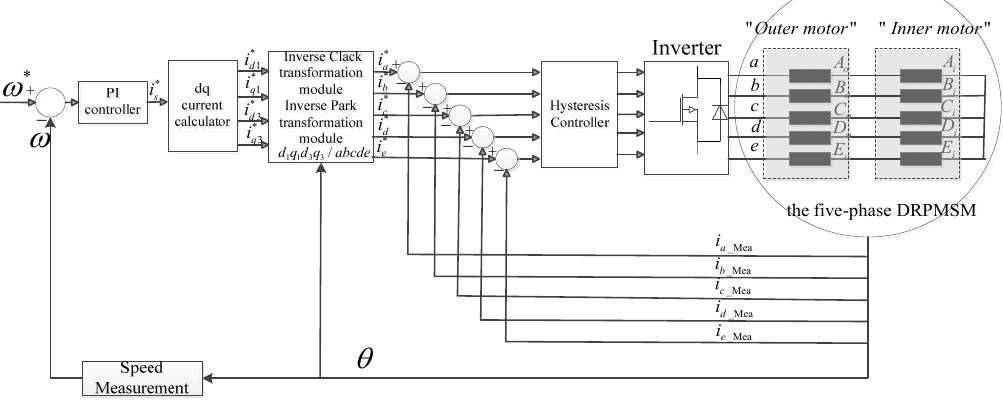
Figure 2. The control block diagram of five ‐ phase DRPMSM in series drive mode under normal operation.